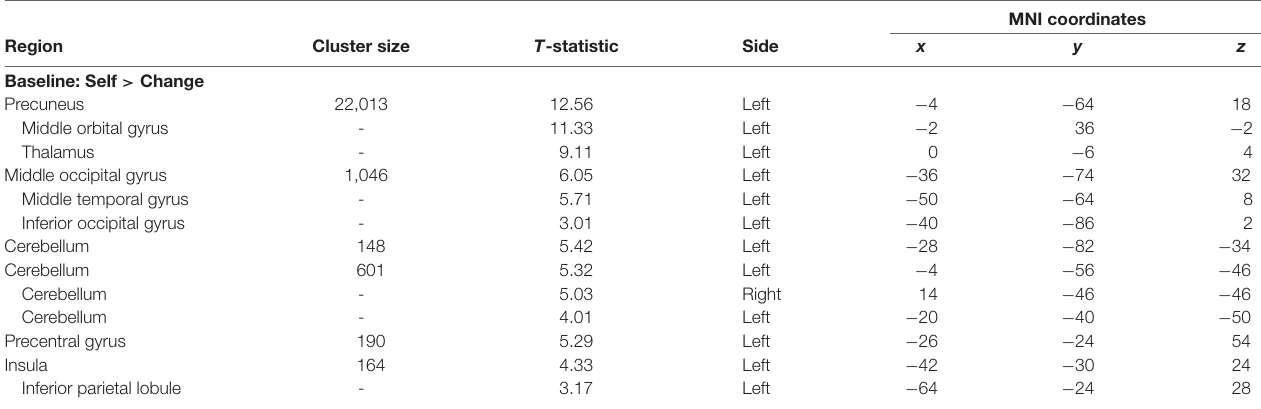
TABLE 4 | Peak voxel and maximum T -values for PSET baseline